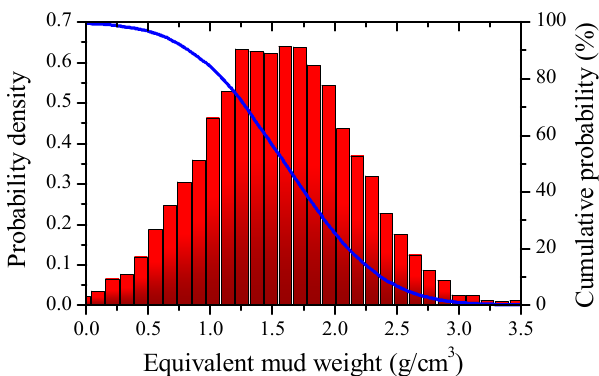
Figure 13. Probability density and cumulative probability for EMWFP.